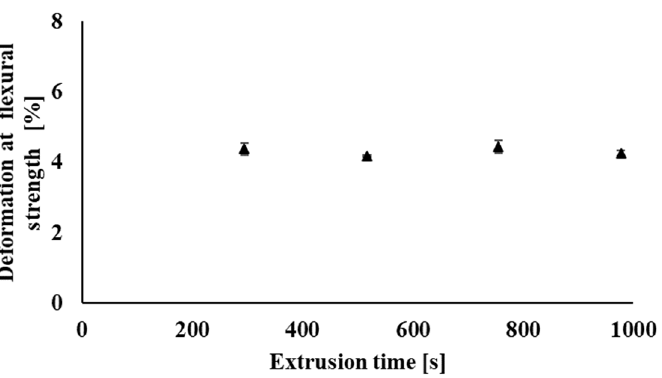
Figure 18. Dependence of maximum flexural strength on the total processing time of the material in the form of filaments processed under industrial conditions.